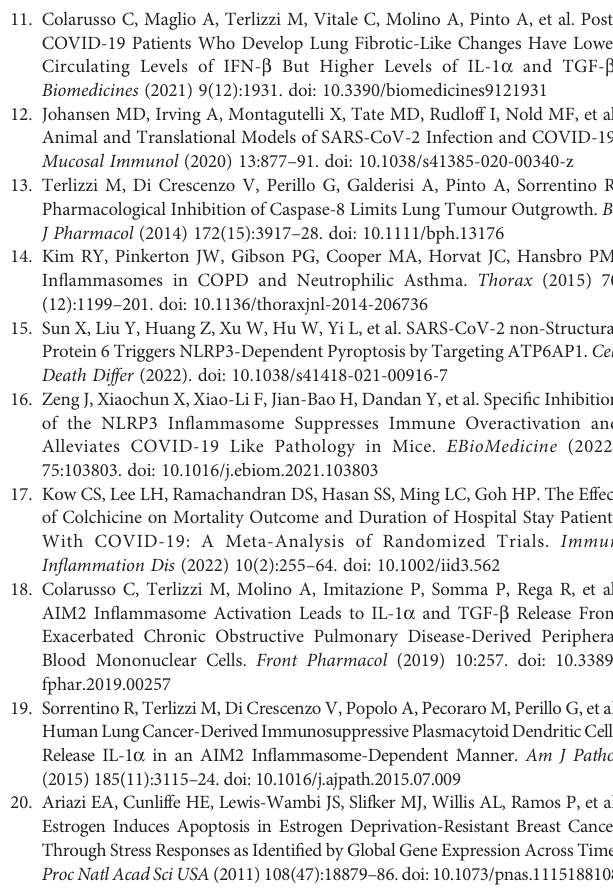
Supplementary Figure 1 | Stimulation with Poly dA:dT (1 m g/mL) for 5 hours did not lead to the release of IFN- b from Post-COVID-19 (PC)-derived PBMCs, even when patients were strati fi ed according to the (A) absence or (B) presence of signs of lung fi brosis on chest CT scan. Data are reported as median and represented as scatterdotplots.StatisticalanalysiswasperformedusingtheMann – WhitneyUtest. Supplementary Figure 2 | Levels of TGF- b in matched pairs of PBMCs from Post-COVID-19 (PC) patients withsigns oflung fi brosis after (A) cGAS or (B) STING inhibition with G140 (2 µg/mL) or H-151 (H151, 1 m g/mL), respectively, following AIM2 stimulation with Poly dA:dT (1 m g/mL). Data are represented as scattered dot plots. Statistical analysis was performed using the Wilcoxon t Test. Supplementary Figure 3 | Visualization of RT-PCR products using 2% agarose gel electrophoresis. RT-PCR product length of AIM2 mRNA was of 158